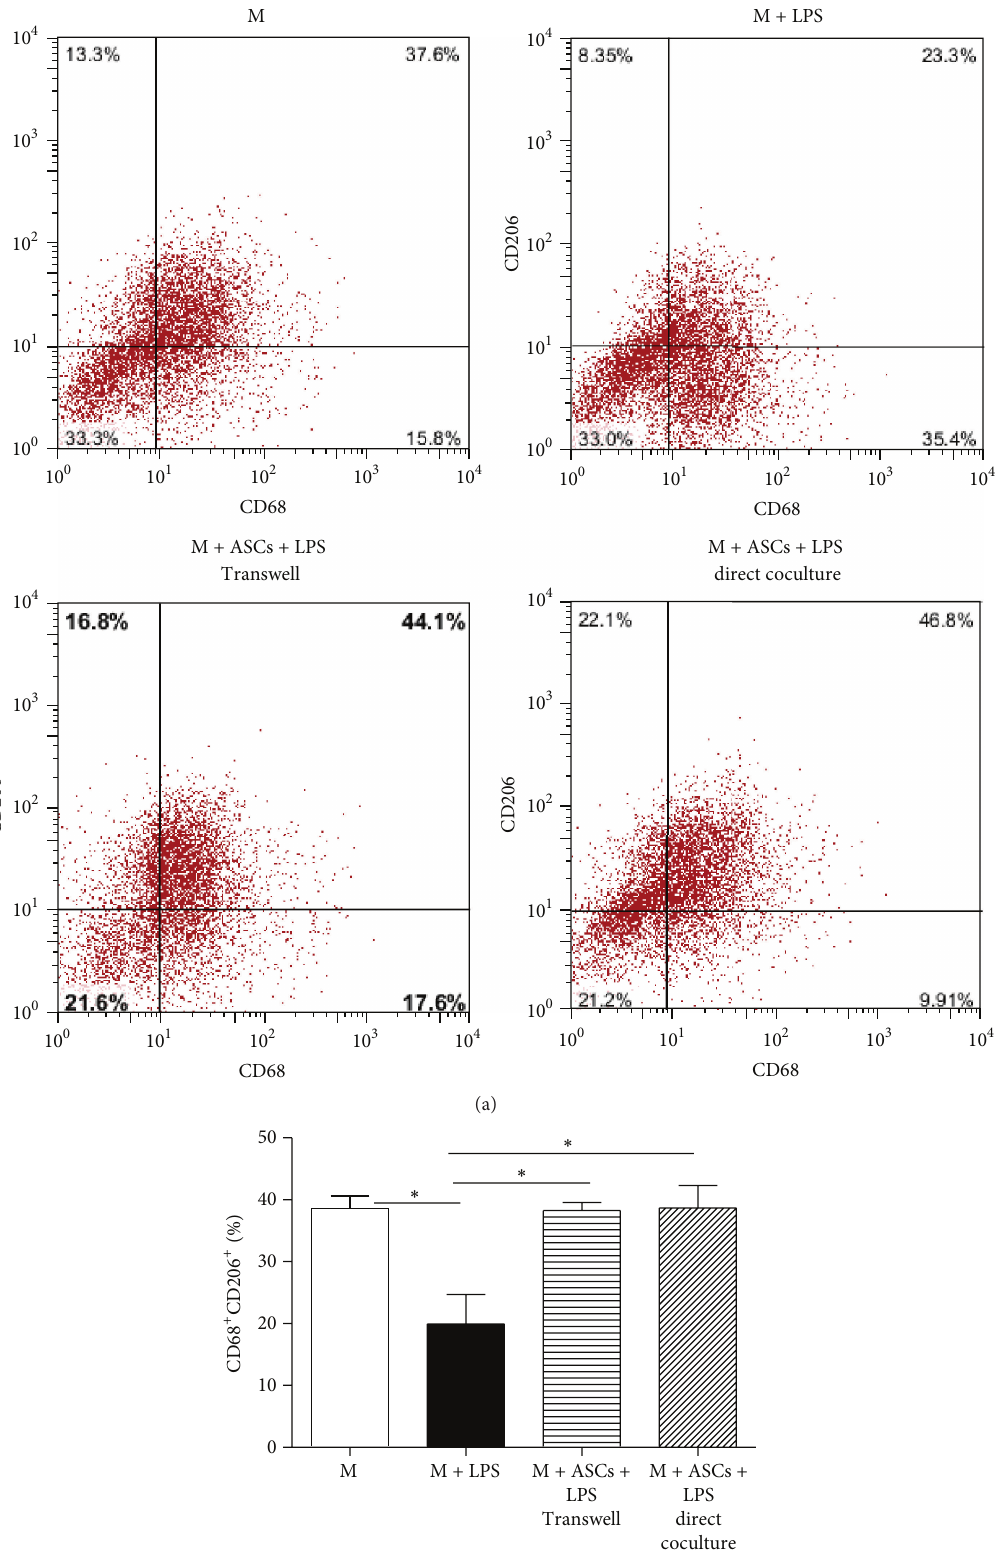
Figure 4: ASCs increase the expression of CD206 + CD68 + macrophages independent of direct cell-to-cell contact. (a) Macrophages (M) (2 × 10 6 cells/well) were cultured alone or cocultured with ASCs for 48 h via Transwell or direct culture (M:ASCs ratio = 4: 1). Cells were then washed and incubated with fresh culture medium for 24h with or without LPS (10ng/mL). The expression of CD206 + CD68 + M was analyzed via flow cytometry. (b) Percentage of CD206 + CD68 + macrophages. All data are expressed as mean ± SEM; 𝑛 = 4 per group. ∗ 𝑝 < 0.05